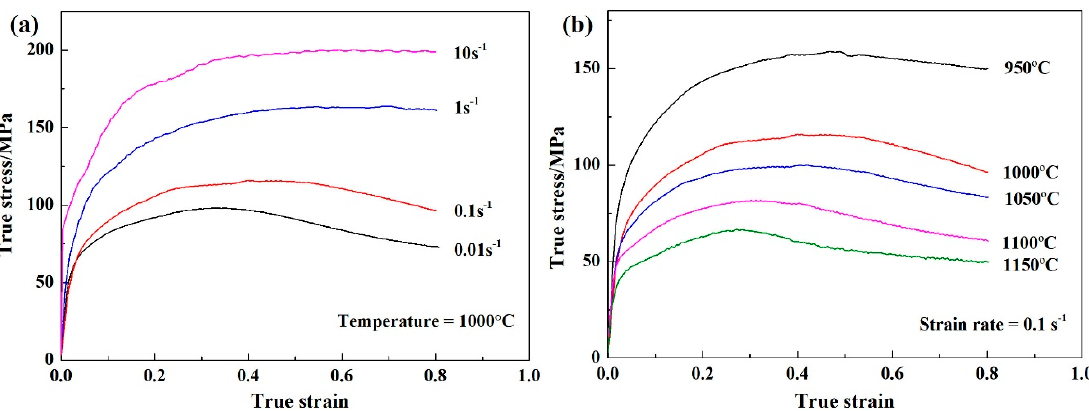
Figure 4. Typical true stress–true strain curves of the nitrogen-bearing martensitic stainless steel under different deformation conditions: ( a ) temperature = 1000 °C; ( b ) strain rate = 0.1 s − 1 .